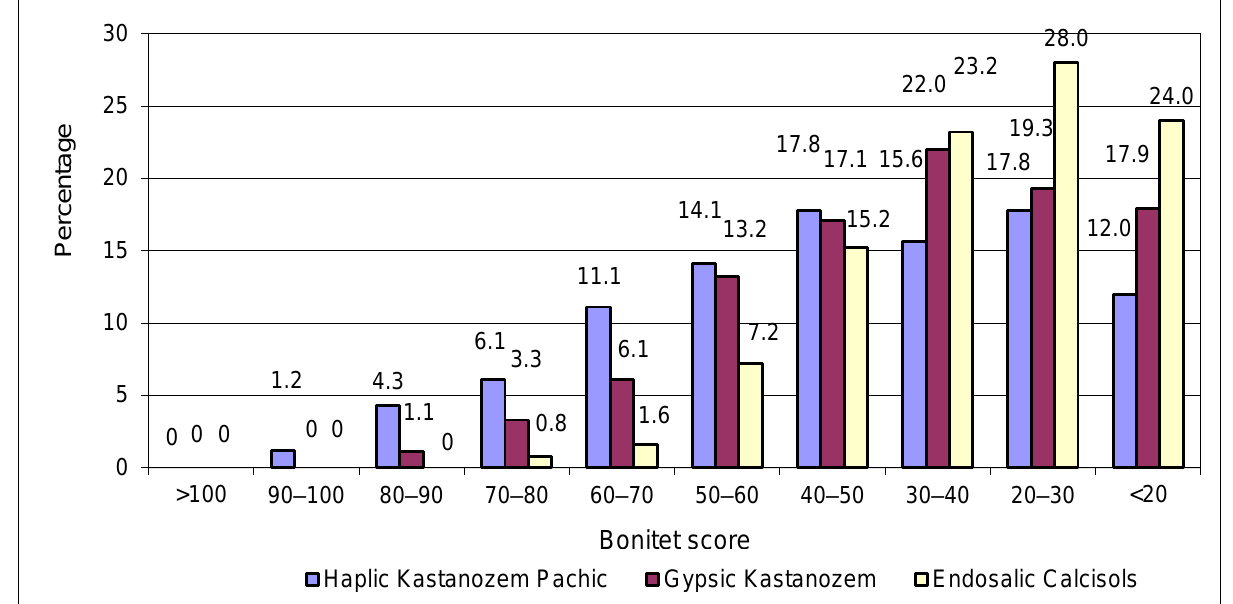
Figure 3. Quality ranking of Kastanozem.